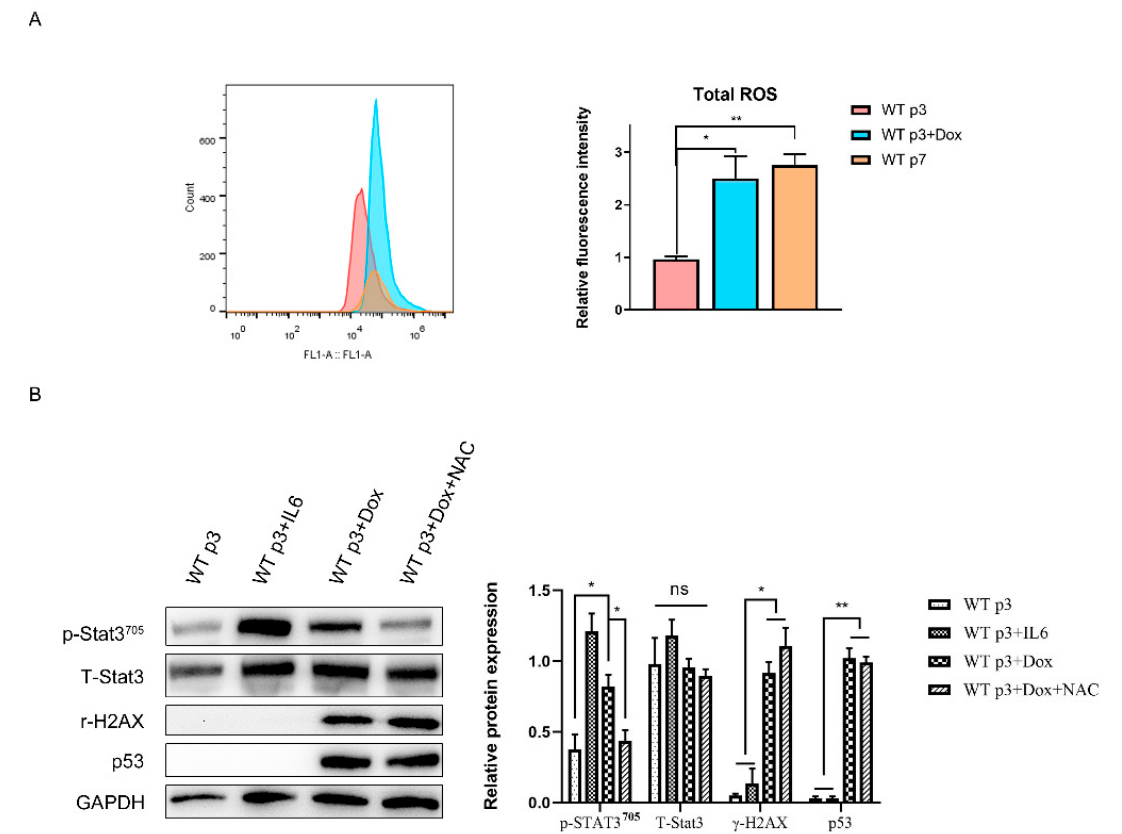
Figure 5. High level ROS active Stat3 pathway in senescent fibroblasts. ( A ). The ROS level of young fibroblasts (p3), senescent fibroblasts (treated with dox or replicative senescence). Quantifi- cation of relative ROS level with relative fluorescence intensity. Statistical analysis. *, p < 0.05, **, p < 0.01. ( B ). The expression of Stat3 and p-Stat3, r-H12x and p53 in fibroblasts were analyzed by Western blotting. They were treated with IL6 as a positive control. Statistical analysis; *, p < 0.05, **, p < 0.01 and ns indicate non-significance.